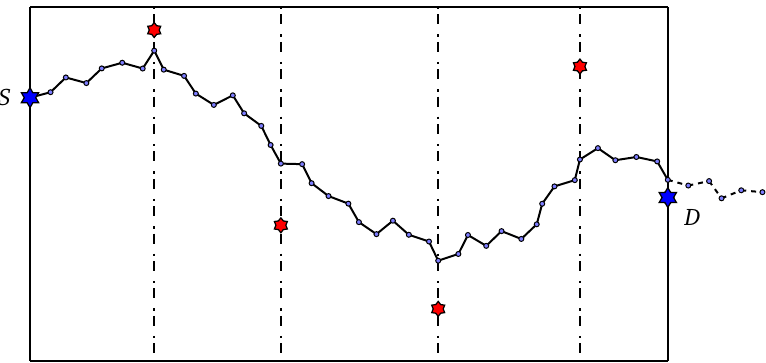
Figure 3. Red stars are the control points that drive the path.